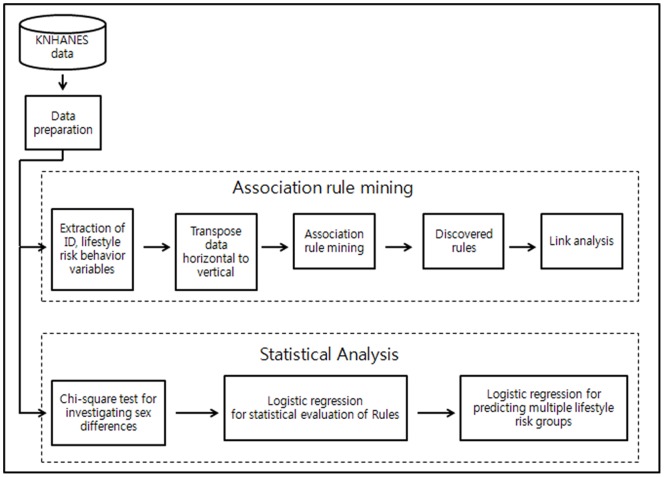
Analysis framework.